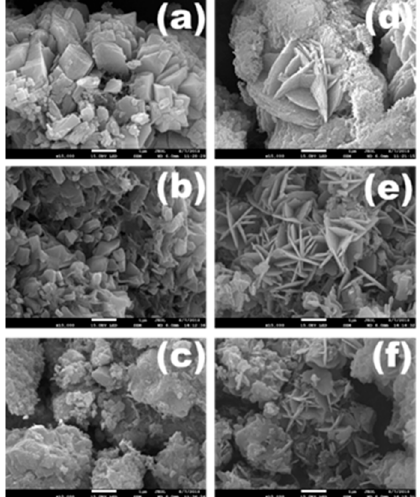
Figure 4. Scanning electron microscopy (SEM) images of the synthesized zeolite from the waste to waste stream combination, using the Al dross and waste LCD glass with weight ratios of ( a ) 0.3:1, ( b ) 0.5:1, ( c ) 1:1, ( d ) 2:1, ( e ) 3:1 and ( f ) 4:1 using 2 M NaOH hydroxide.